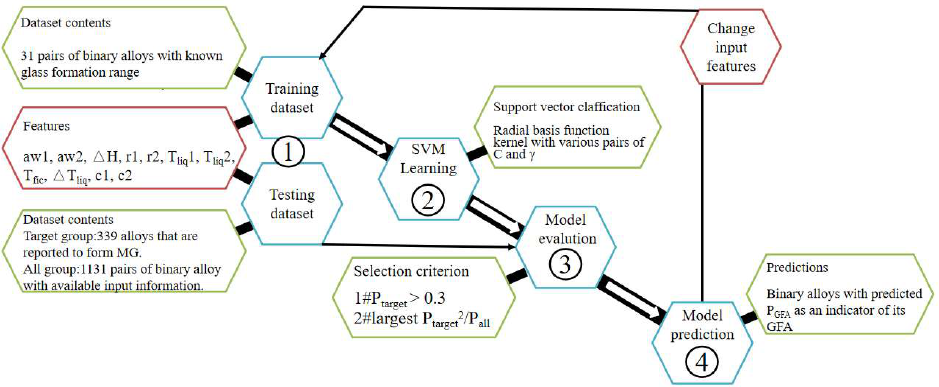
Figure 2. Overall setup for SVM modeling. Reprinted (adapted) with permission from SUN [54]. Copyright 2017 American Chemical Society.